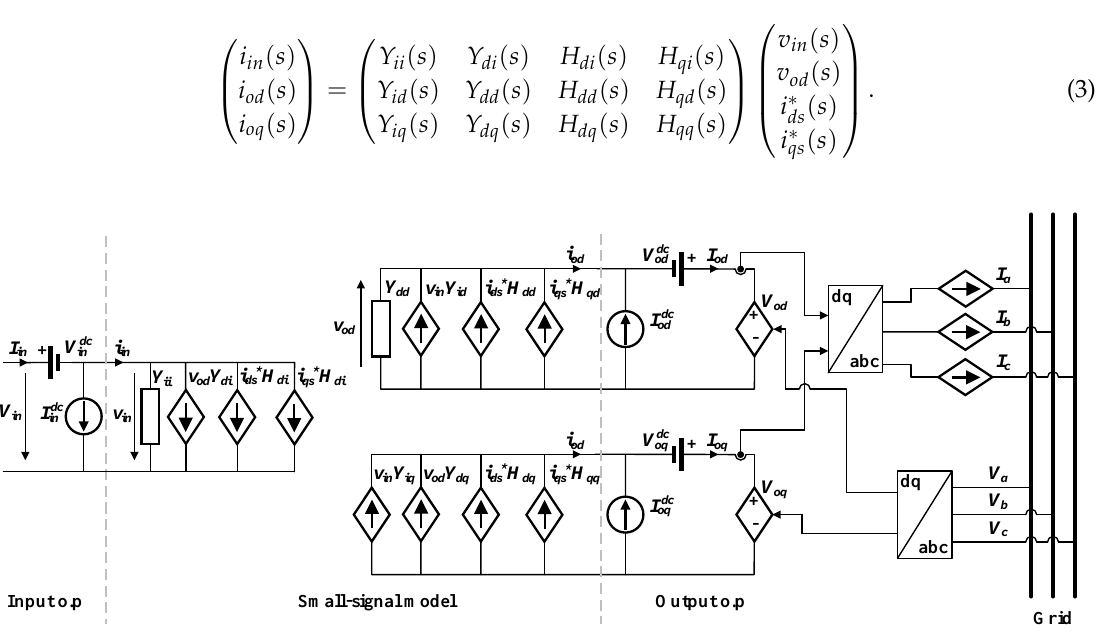
Figure 2. Equivalent electrical circuit of the EPC